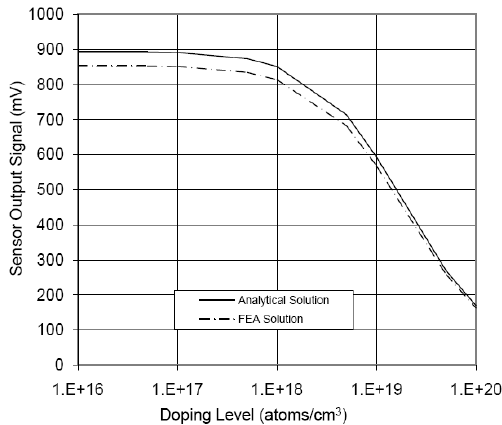
Figure 5. Comparison between FEA results and analytical results of flat sensing chip with full-bridge configuration at room temperature (25 °C) for light doping concentrations (less than 5 × 10 18 atoms/cm 3 ), V = 5 V. i